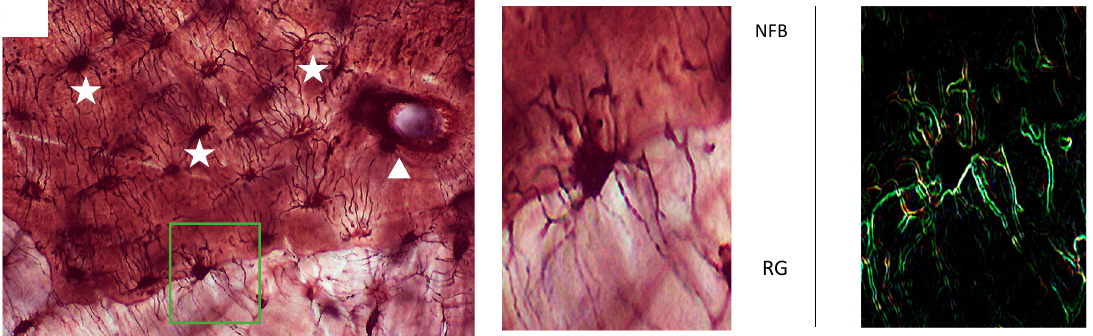
Figure 4. Undecalcified section of lamellar bone (details of Figure 3) ( 1 ) interface between NFB and